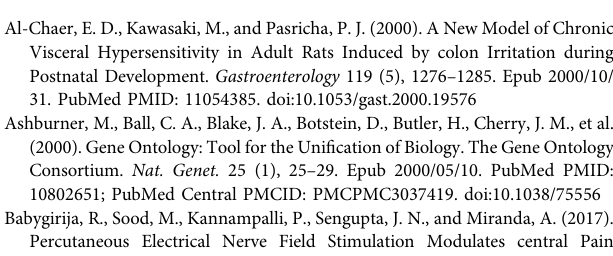
Supplementary Figure S1 | Total ion currents (TIC) chromatograms of the major constituents in CKF. The compounds are detected under positive (A) and negative (B) mode, respectively. Supplementary Figure S2 | Schematic diagram of the relationship between metabolic pathways and metabolite identi fi ed by the analysis of serum samples in Normal and CKF group. Supplementary Figure S3 | Metabolism-protein networks for neuroactive ligand- receptor interactions (A) and serotonergic synapses (B) . ○ Metabolites █ Key protein targets. Supplementary Figure S4 | Association map for the four-tiered analyses integrating the gut microbiome, phenotypes, molecular biology indicators, and serum metabolites. The intensities of the colors represent the degree of association, (red) positive correlation or (blue) negative correlation. |r| ≥ 0.5, * p <